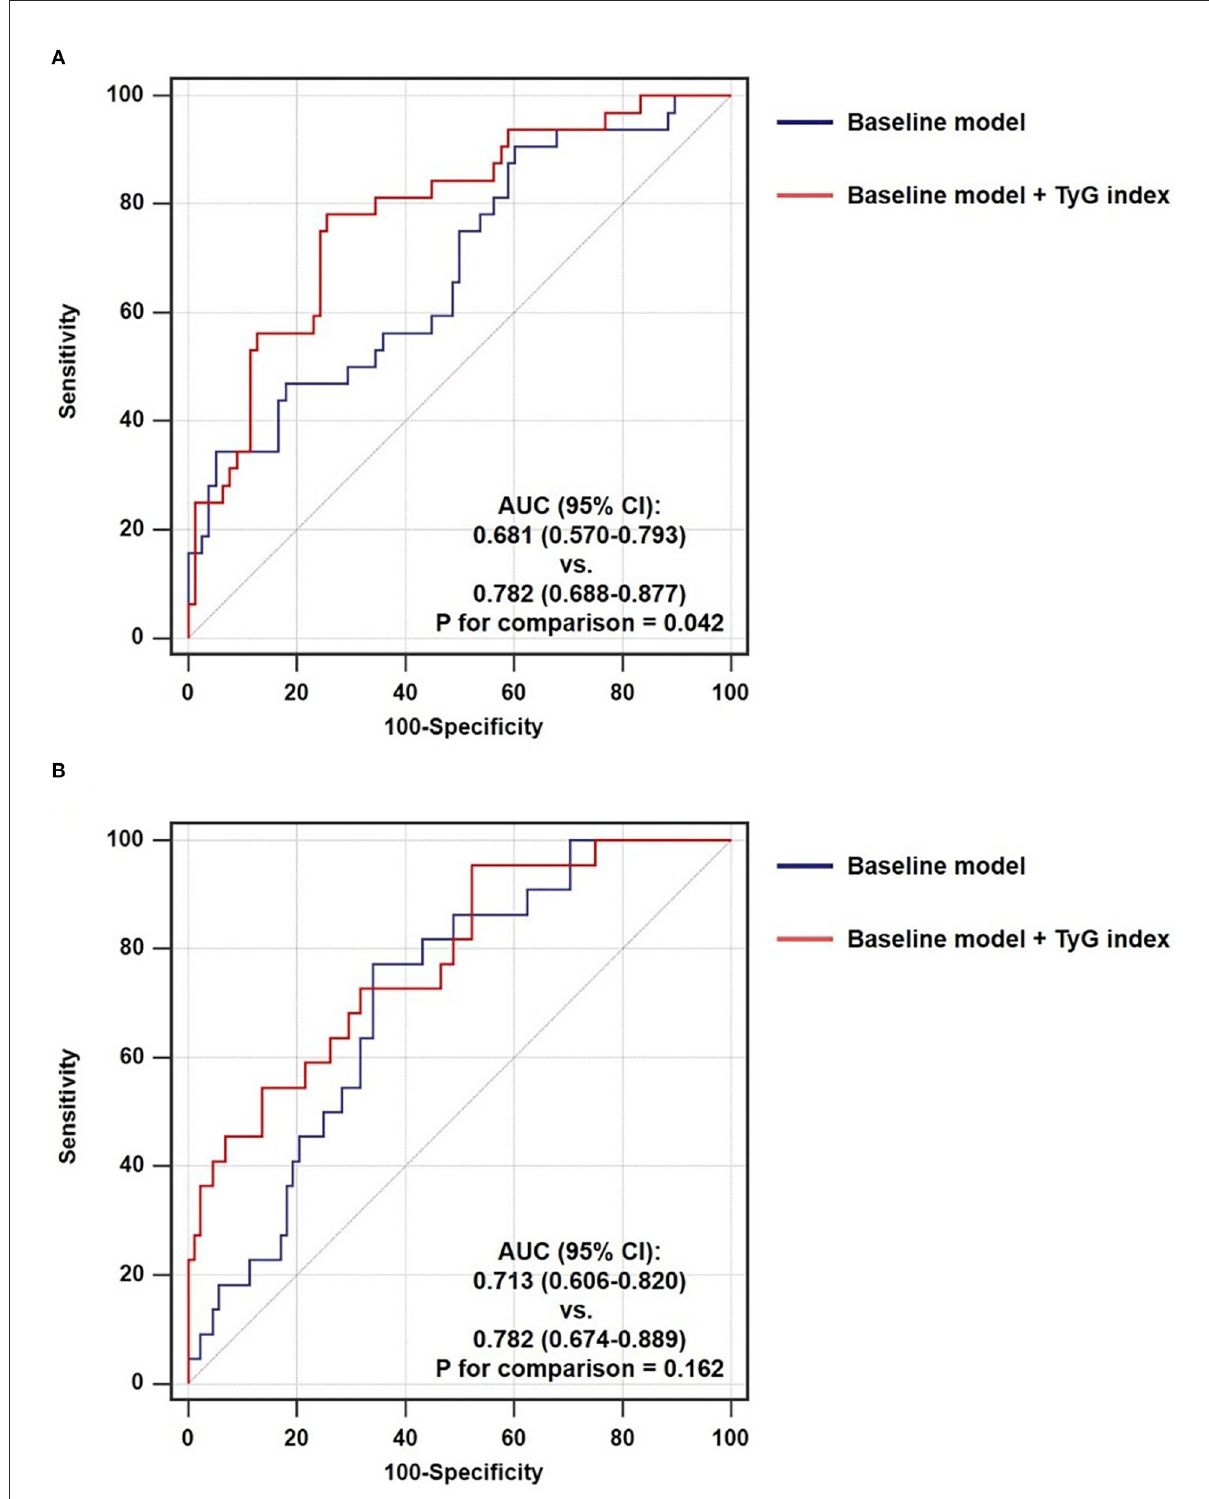
FIGURE5 Incremental ability of TyG index on the prediction of non-culprit (A) TCFA and (B) ruptured plaque beyond a baseline model. AUC, area under the ROC curve; CI, confidence interval; TyG,